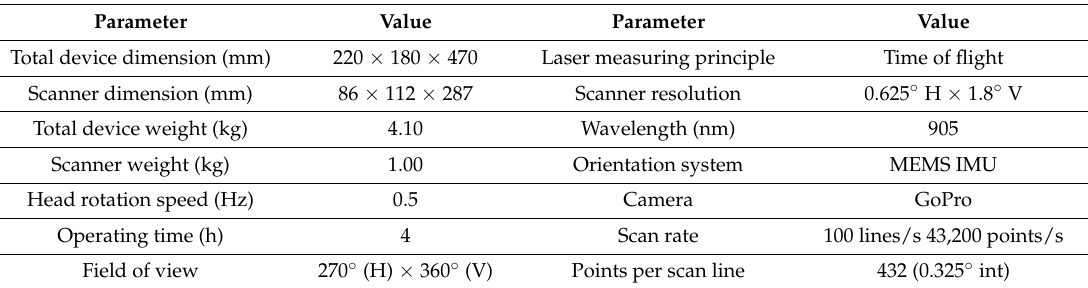
Figure 2. Methodological phases of the procedural pipeline for surveys with a WMLS.